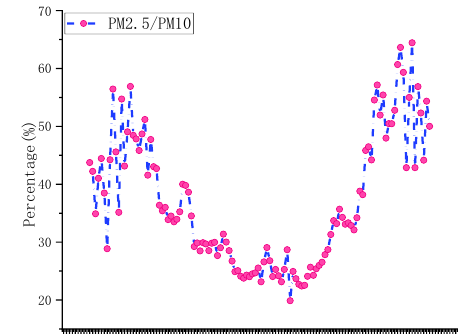
Figure 6. Concentrations of PM 2.5 and PM 10 in